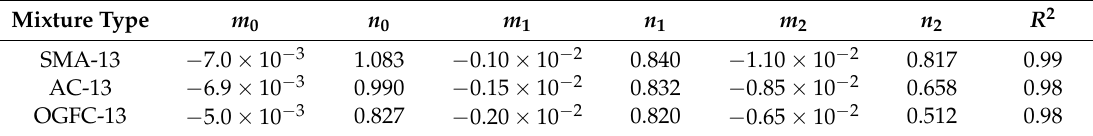
Table 8. Strength parameters of asphalt mixtures by linear failure envelope.